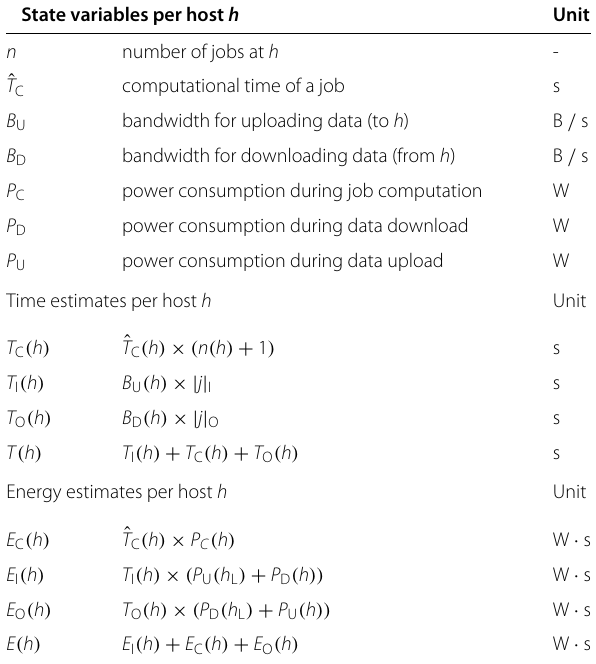
Table 2 Summary of model